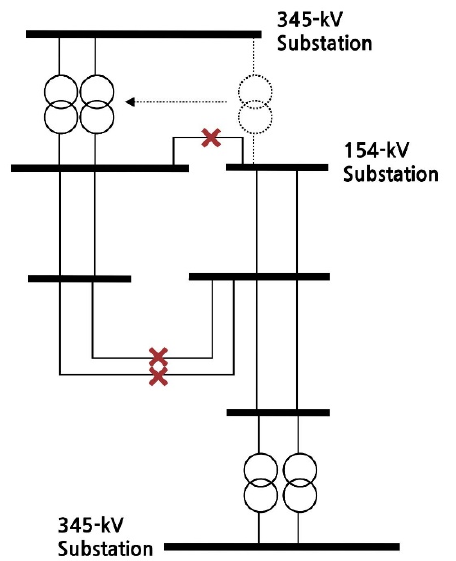
Figure 4. Line separation method with an insufficient transformer capacity.